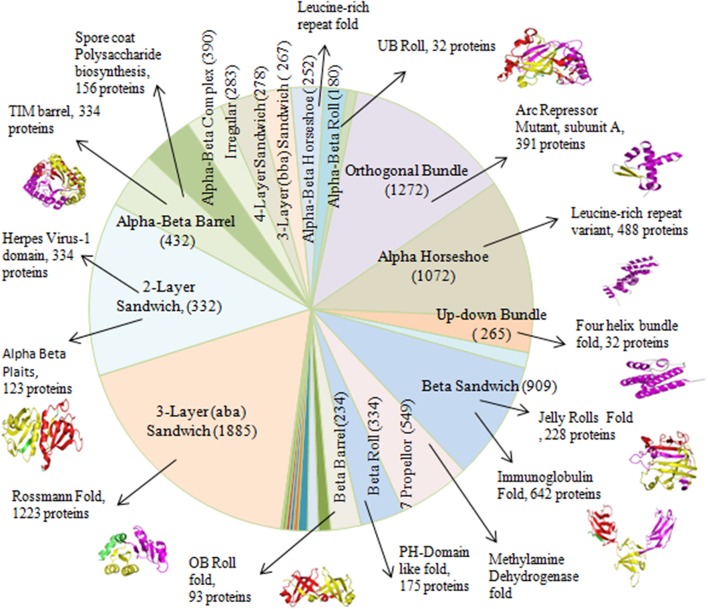
The occurrences of certain folds of Arc Repressor Mutant subunit A of Orthogonal bundle architecture, Four helix bundle of Up-down bundle, Jelly Rolls and Immunoglobulin of Beta sandwich, PH-Domain like fold of Beta Roll, OB Roll of Beta Barrel, Rossmann fold of 3-layer sandwich, Alpha Beta plaits, and Herpes Virus-1 domain of 2-layer sandwich, TIM barrel of Alpha-Beta Barrel and UB Roll of Alpha-Beta Roll in a substantial numbers of Long repeats proteins.